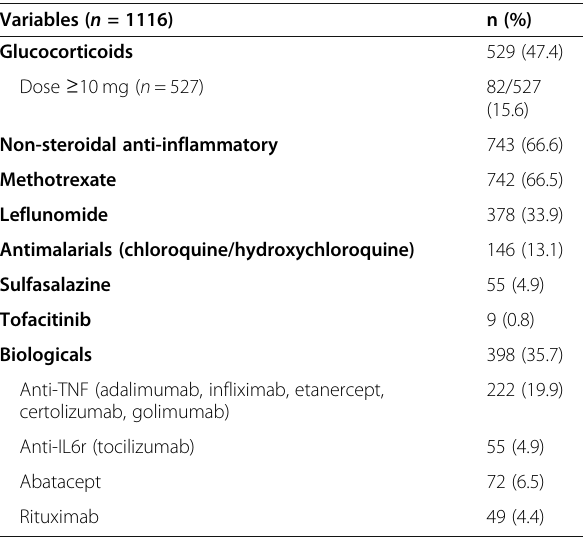
Table 3 Drugs used for rheumatoid arthritis treatment in the population of the REAL study